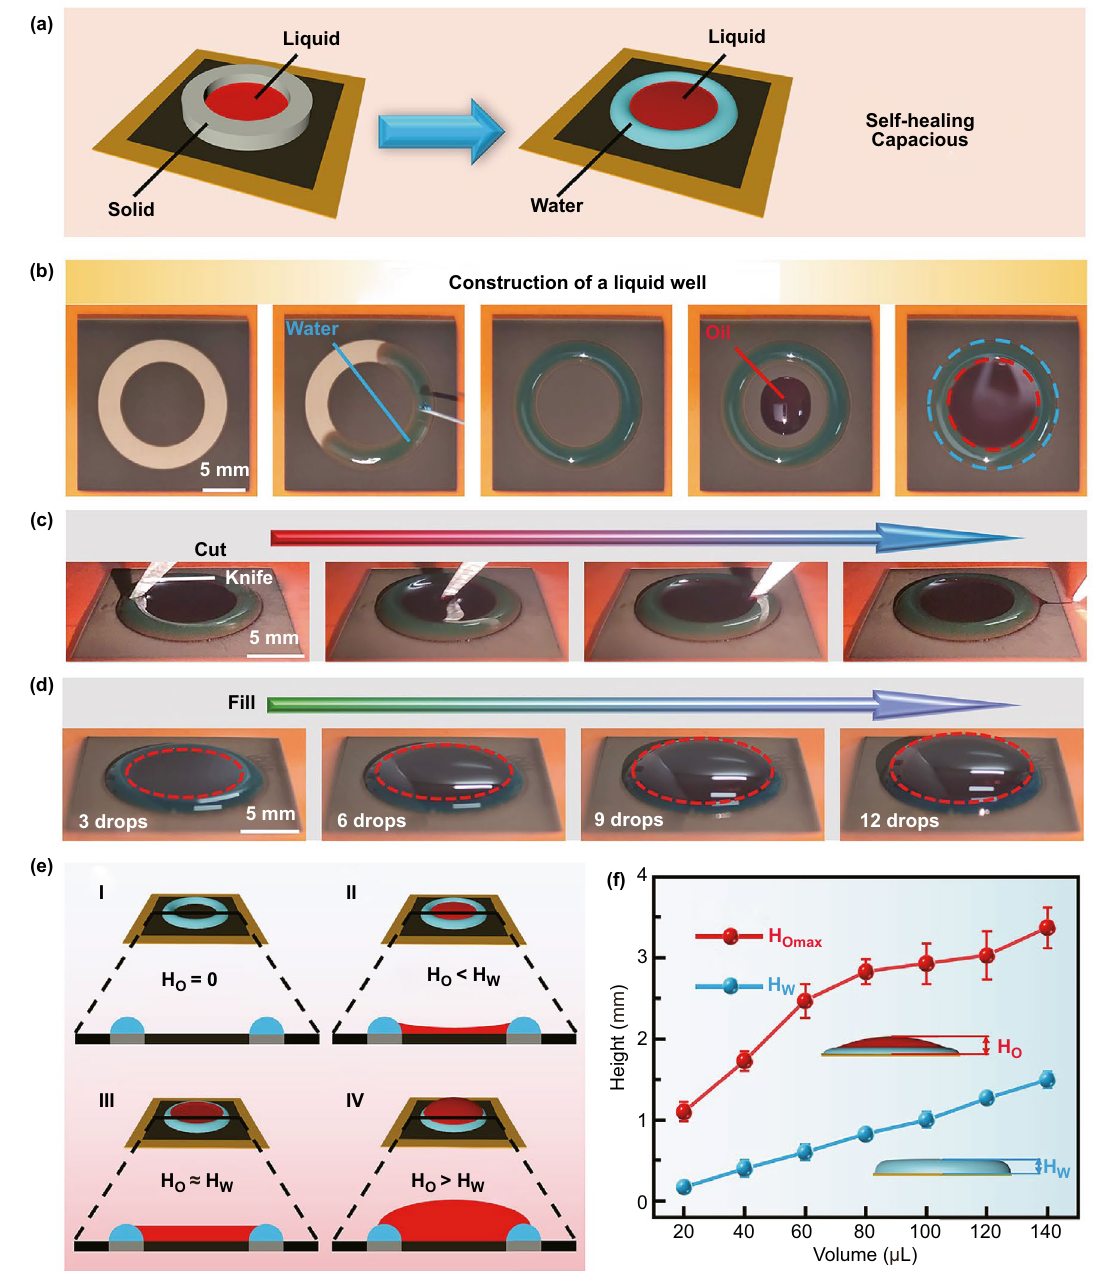
Fig. 5 a Scheme diagram of a liquid contained in a solid vessel and inside a liquid well. b Optical photographs for the construction of a circular liquid well. Water constructed an annular water wall on the superhydrophilic areas. Oil was then added into the water wall. The inner and outer diameters of the superhydrophilic areas were 10 and 15 mm, respectively. c The self-healing properties of the liquid well using a knife to cut the liquid well. d A series of optical photographs for the liquid well with the increase in oil. e Scheme diagram for a cross section of the liquid well with different volumes of contained oil. f Maximum heights of the contained oil and height of an annular water wall as functions of water vol- ume. All the used water and oil were dyed with Methylene Blue and Oil Red,